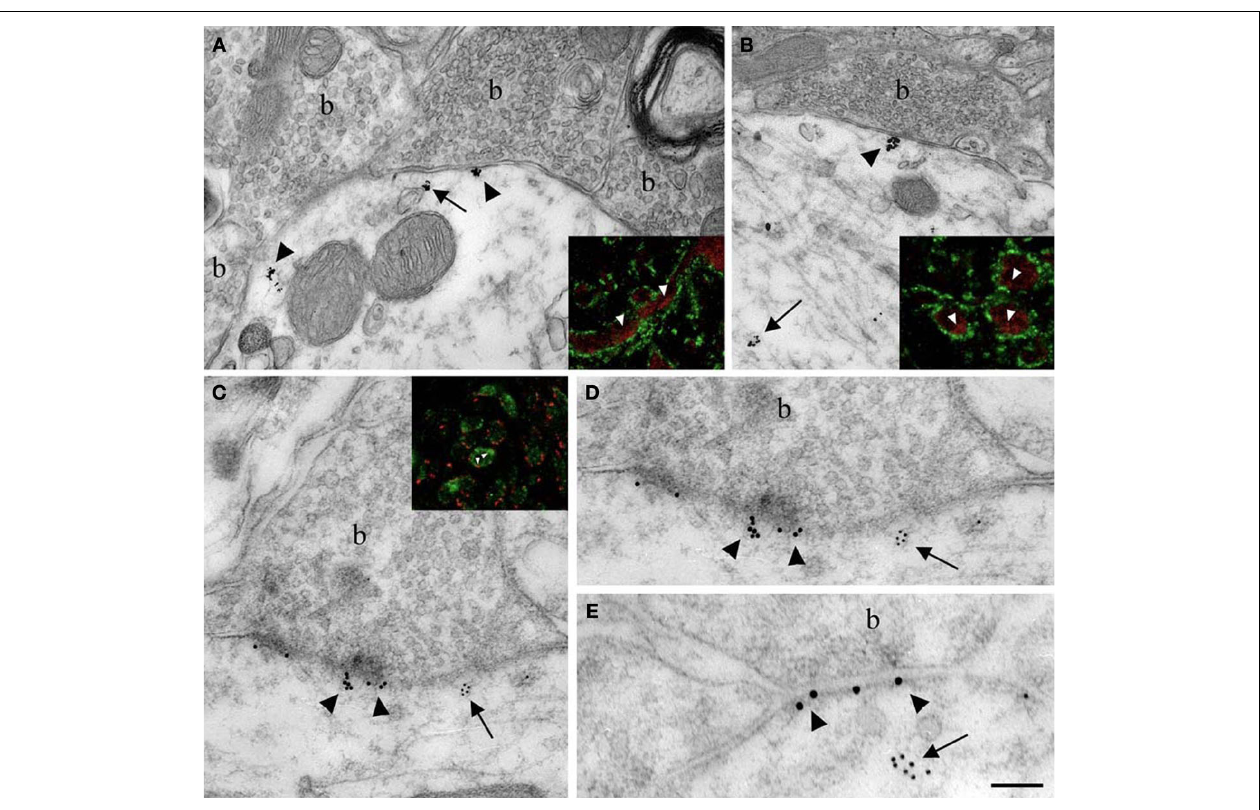
(10 nm gold particles; arrows) is found beneath postsynaptic regions where gephyrin immunoreactivity (15 nm gold particles; arrowheads) decorates and identifi es inhibitory synapses. (D) High magnifi cation of the postsynaptic cytoplasm of (C) . Inset in (C) , Double-immunofl uorescence of Nova (in green) and gephyrin (in red) showed that Nova immunoreactivity is observed in proximity of gephyrin immunoreactivity synaptic contacts (arrowheads). Scale bar: 0.2 µm (A) ; 0.6 µm (B) ; 0.2 µm (C,E) ; 0.4 µm (D) ; 9 µm (insets in A,B ); 6 µm (inset in C